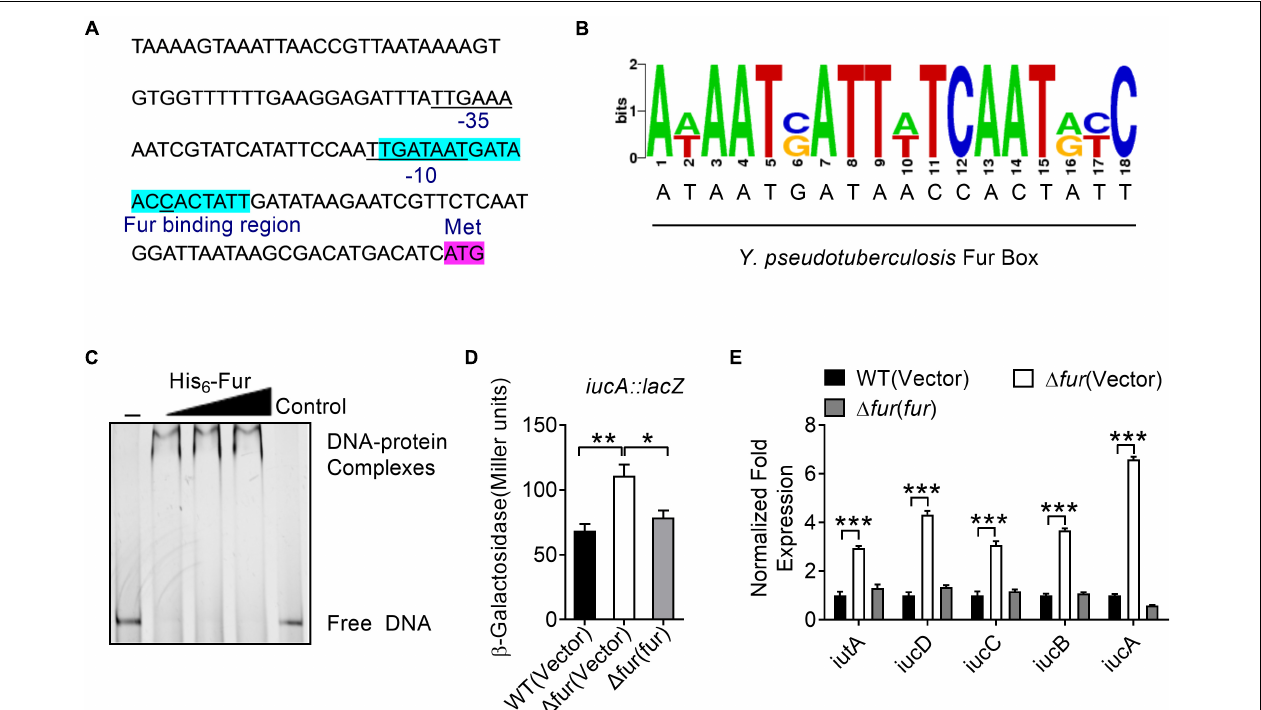
FIGURE 3 | Ferric uptake regulator (Fur) negatively regulates the iucABCD - iutA operon expression in Y. pseudotuberculosis . (A) Identification of a Fur-binding site in the promoter region of iucABCD - iutA . The putative Fur-binding site identified by the online software Virtual Footprint is indicated by blue highlighting. Putative − 35 and − 10 elements of the iucABCD - iutA promoter are underlined. The ATG start codon of the first ORF of the iucABCD - iutA operon is shown. (B) Fur box sequence upstream of iucA. Virtual footprint analysis of the Y. pseudotuberculosis Fur-binding sequence. Letters represent position weight matrix based on E. coli K-12 consensus sequence for Fur binding. The Y -axis represents relative nucleotide probability and the X -axis represents nucleotide position. Y. pseudotuberculosis Fur box sequence is located at − 64 bp of iucA and has a probability score of 28.50/0 (max score = 28.50). (C) Electrophoretic mobility shift assay (EMSA) was performed to analyze the interactions between His 6 -Fur and the promoter. Increasing amounts of Fur (0, 0.24, 0.48, and 0.72 µ M) and 5 ng DNA fragment were used. As a negative control, a 5 ng of 151-bp unrelated DNA fragment was used in control. (D) Fur represses the expression of iucABCD - iutA . β -galactosidase analyses of iucABCD - iutA promoter activities were performed using the transcriptional P iucA ::lacZ chromosomal fusion reporter expressed in the Y. pseudotuberculosis WT, (cid:49) fur mutant, and complemented (cid:49) fur ( fur ) strains grown to stationary phase in YLB medium. (E) qRT-PCR analysis of mRNA levels of iucABCD - iutA . Cells of relevant Y. pseudotuberculosis strains were grown to mid-exponential phase in YLB medium, and the expression of iucA , iucB , iucC , iucD, and iutA were measured by qRT-PCR. Statistical analyses for the rest of the assays were performed using unpaired two-tailed Student’s t -test. Data represent the mean ± SEM of three biological replicates, each of which was performed with three technical replicates. * p < 0.05; ** p < 0.01; *** p <